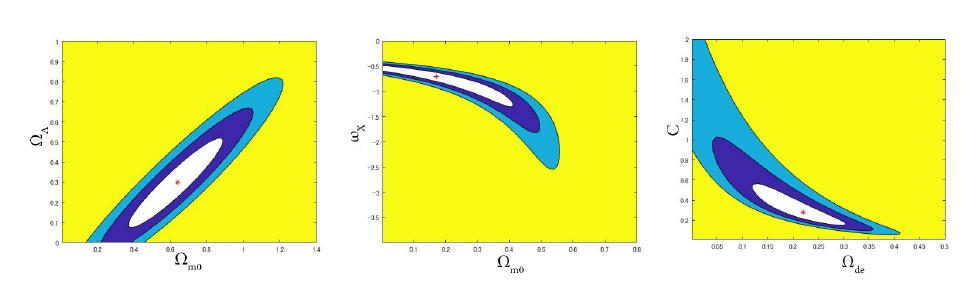
Figure 1. Constraint contours for the Λ CDM (left), XCDM (middle), Holographic model (right) for H 0 = 68 . 0 ± 2 . 0 kms − 1 , from H ( z )